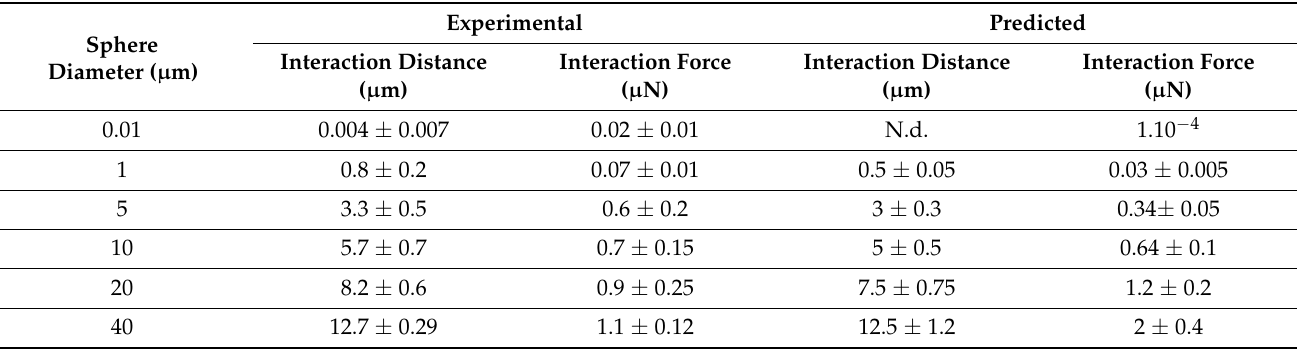
Table 1. Comparison of the repulsive force and distance measured or modeled between the silica surface and different diameter sizes of borosilicate sphere, both of which are functionalized by APTES. The data are collected during three experimental campaigns. For every campaign, new bead and substrate are considered, and force is measured in 10 different locations on a